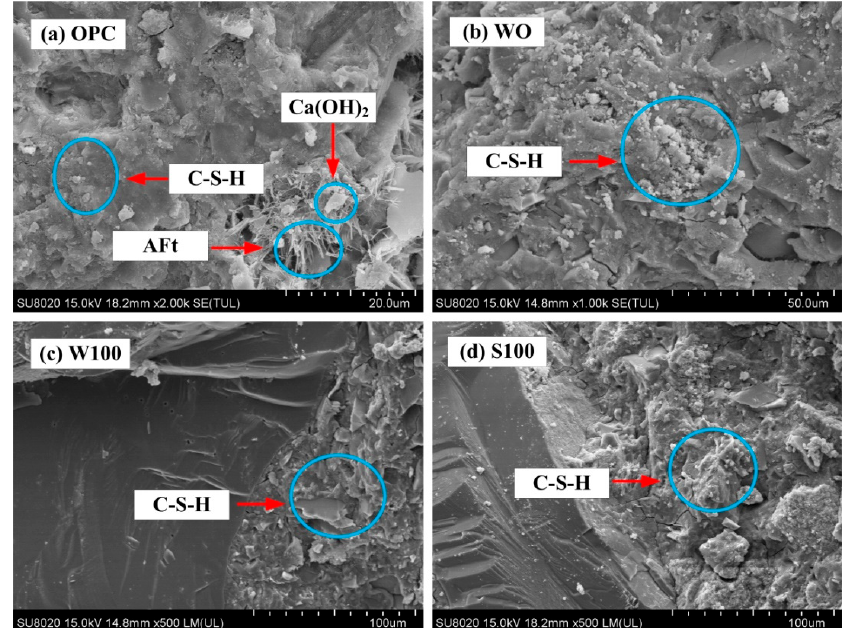
Figure 13. SEM images of the bonding interface between aggregate and cementitious material of ( a ) OPC, ( b ) W0, ( c ) W100 and ( d ) S100.